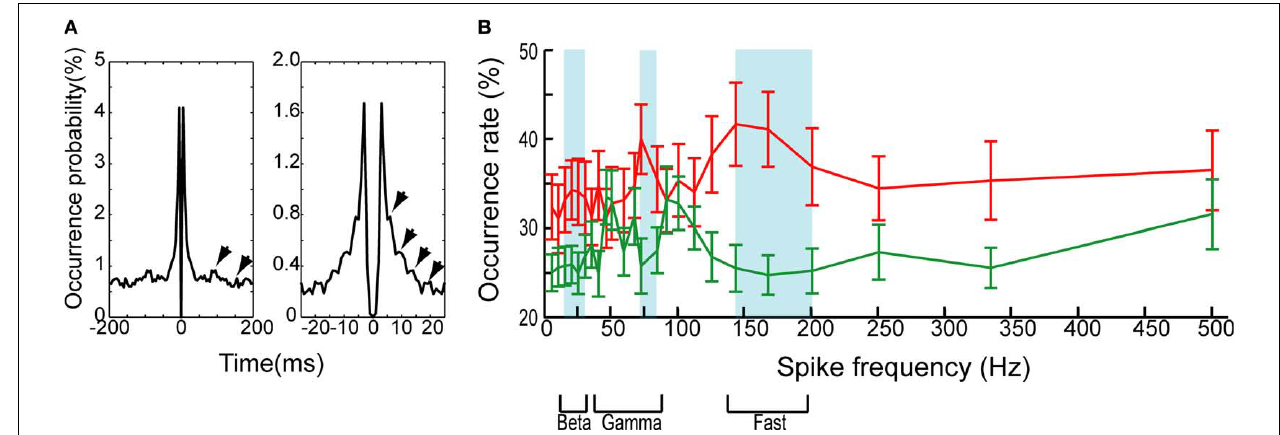
function of the spike frequency. The blue shaded box highlighted bands of signifi cant spike frequency ( t -test; P < 0.05; see Materials and Methods). Error bars show SEM. The lower portion shows the bands of the beta, gamma and fast-ripple